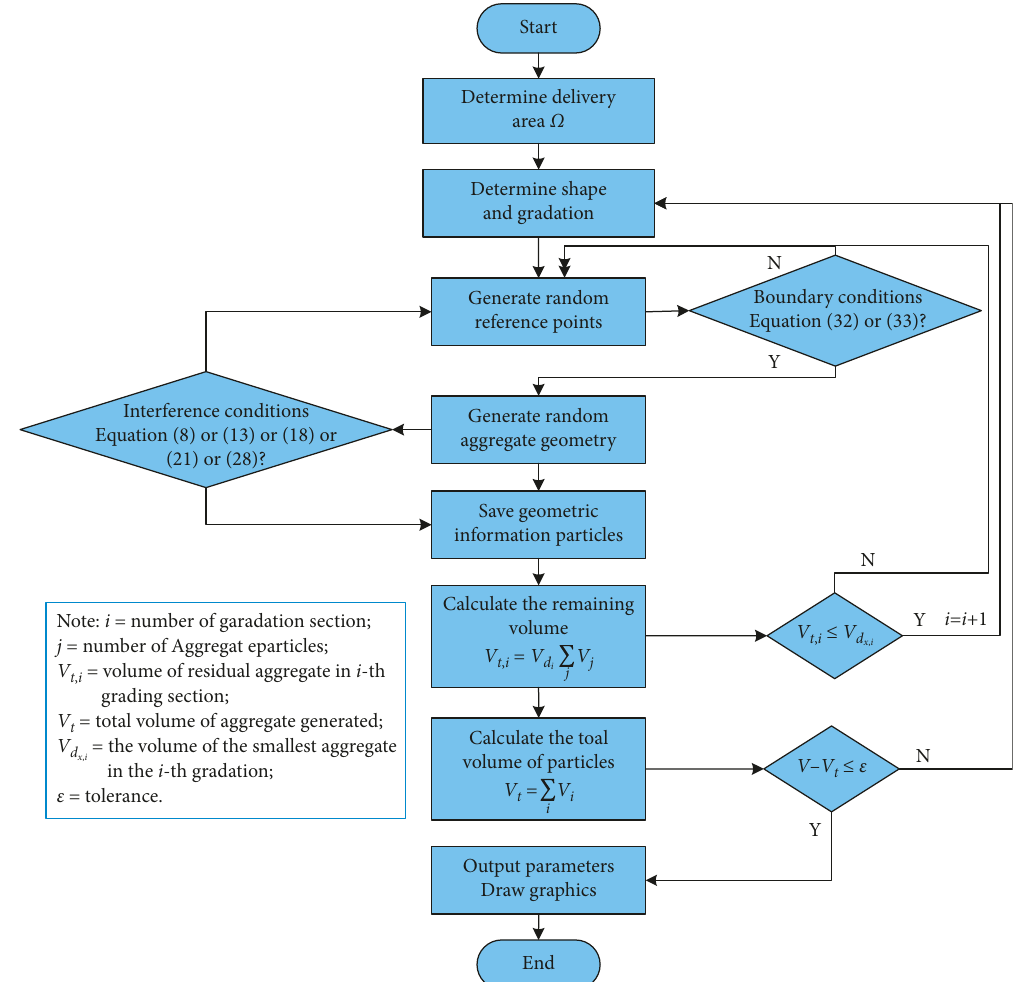
Figure 10: The basic process of stochastic aggregate particles generation and